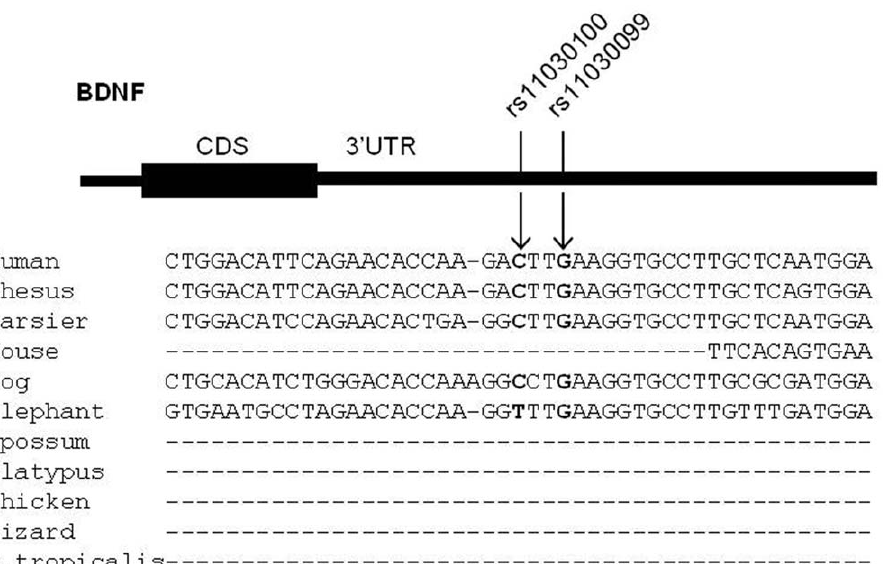
Figure 1. Multiple genome alignment of BDNF 3 9 UTR in the region of polymorphic sites rs11030100 and rs11030099 (in bold letters). Sequence analysis shows that sites are highly conserved among primate genomes.